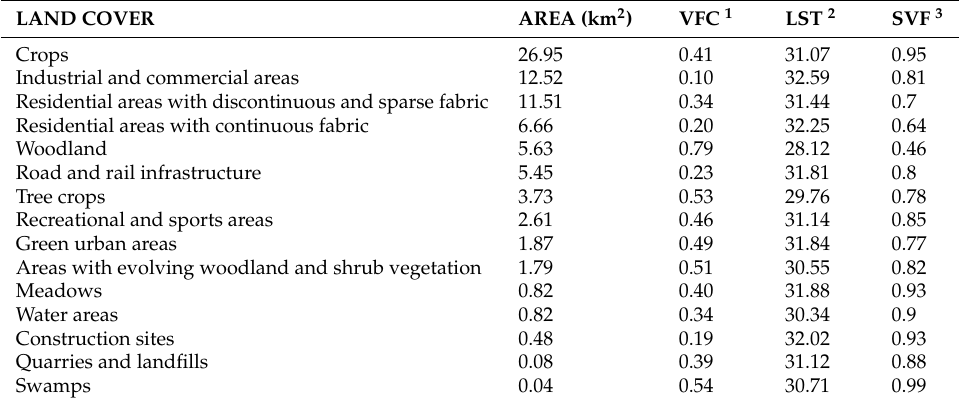
Table 2. Average sky view factor (SVF), vegetation fraction cover (VFC) and land surface temperature (LST) values for the classes of the simplified land cover map (Figure